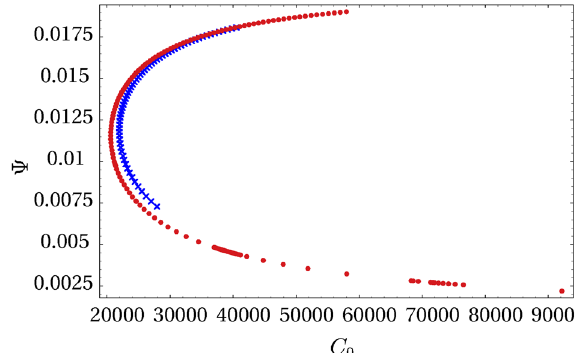
FIG. 12. (Color) Relationship between C potential, (cid:24) . The red circles (outer curve) correspond to ~ rr (cid:1) 0 : 025 and the blue crosses (inner curve) correspond to ~ rr (cid:1) 0 : 030